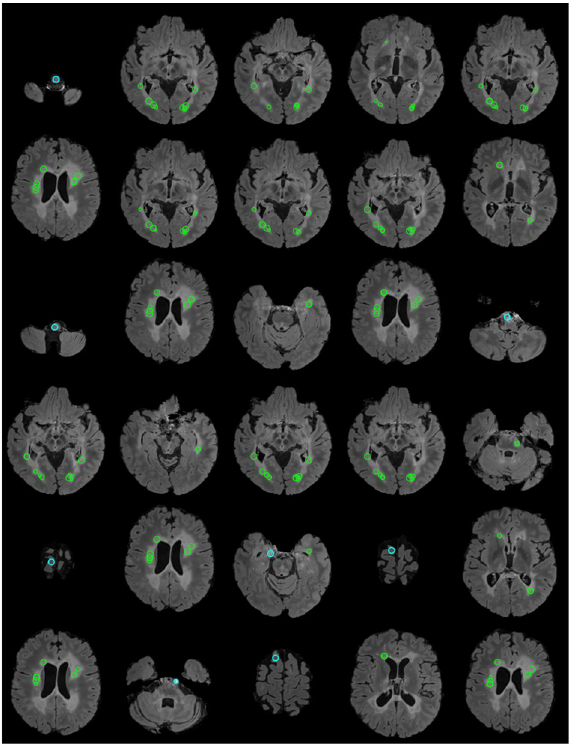
Figure 4. The visualization of the top 30 detected lesions resulting from the proposed O ( N ) -based template matching algorithm on the first case of MSSEG 2016 training data. The green and cyan circles indicate the true and false positives, respectively. Thick and thin circles are detected in the shown and nearby slices, respectively. The top-30 detections are mostly true positives and in the white matter region. False positives are often hyperintense regions mimicking